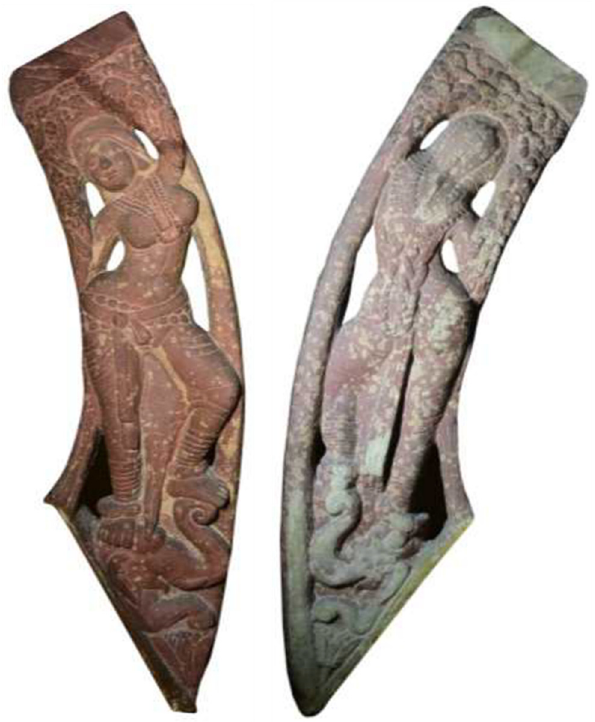
Figure 1. Red sandstone toraṇa with a śālabhañjikā , c. 1st century CE, Mathura, India 6 .